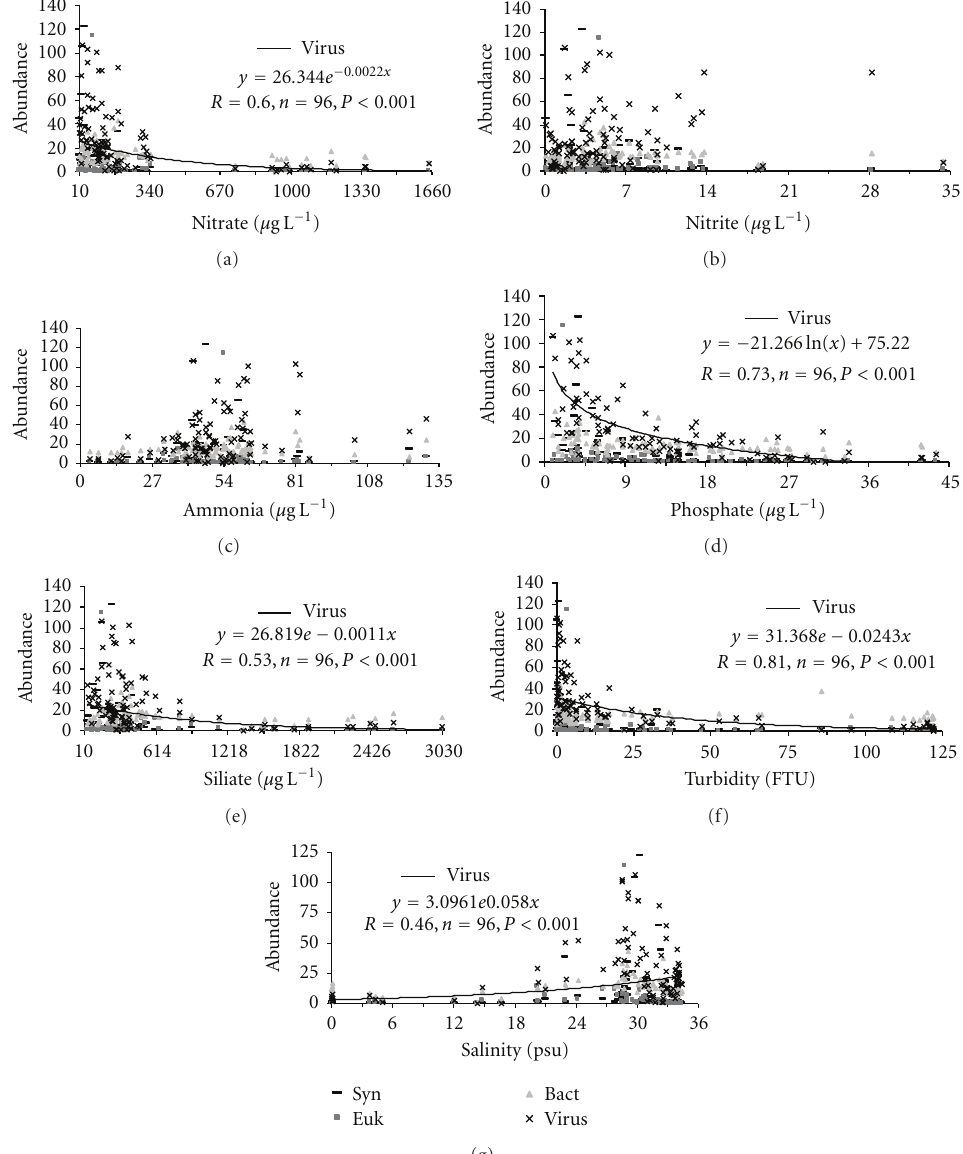
Figure 6: Relationships between the determined biological groups and the environmental parameters (Syn: Synechococcus ; Euk: picoeu- karyotes; Bact: heterotrophic